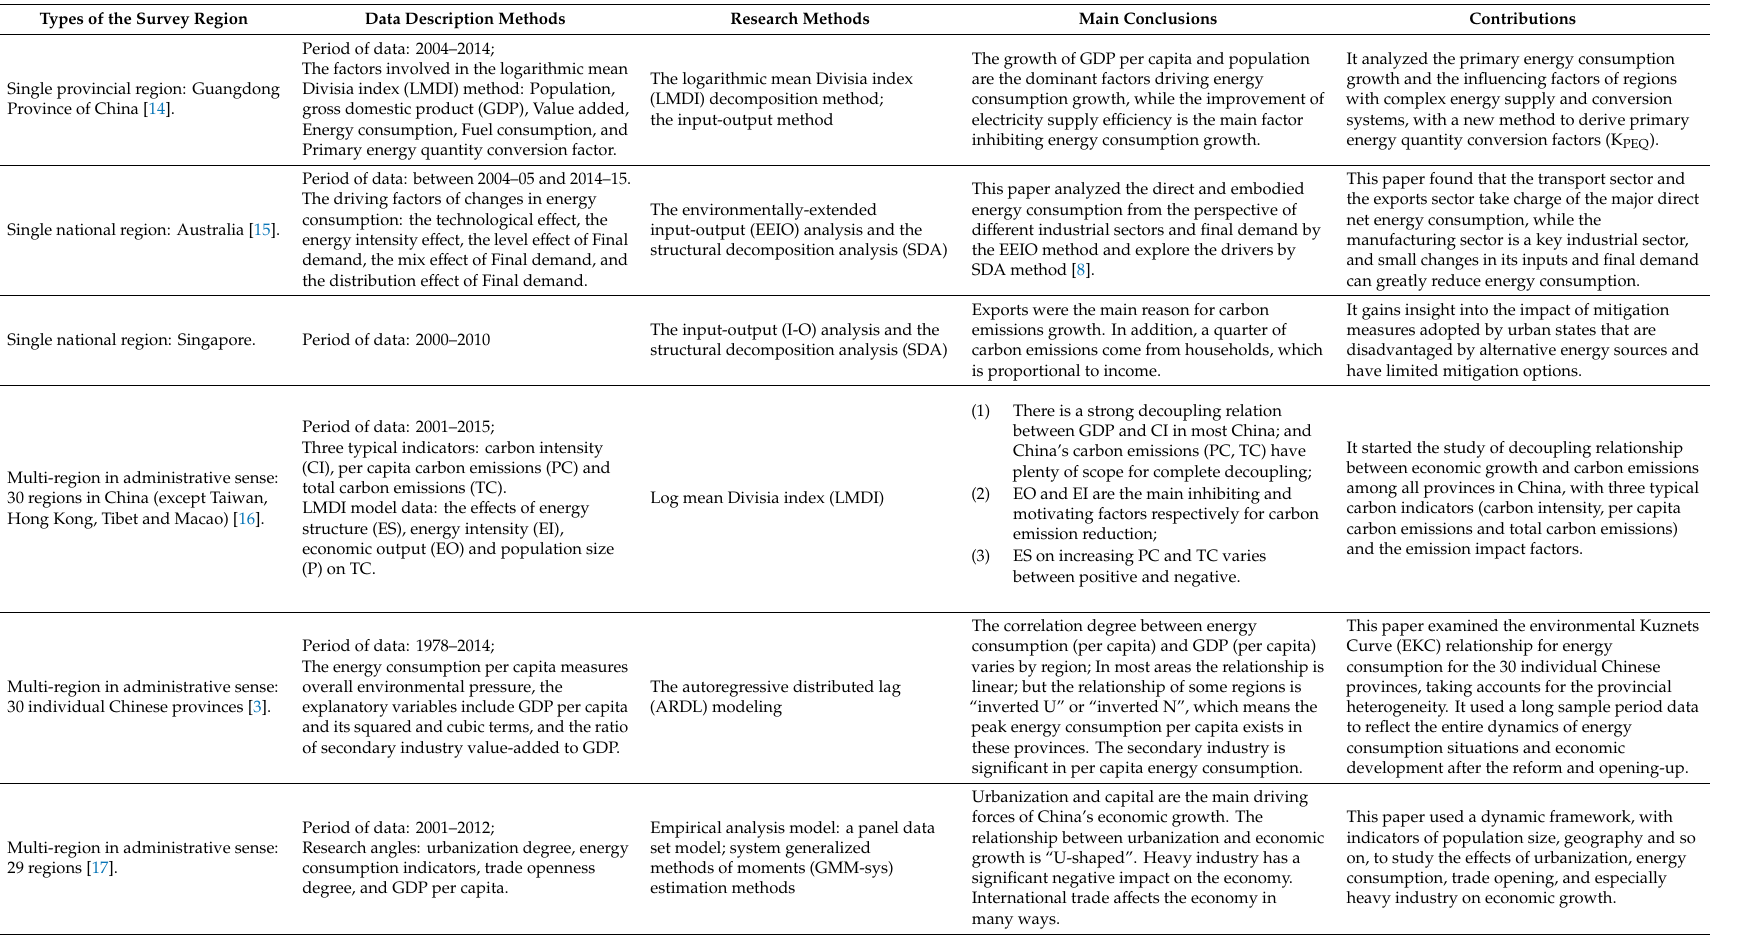
Table A1. Research on description method of changes in energy consumption involving regional di ff